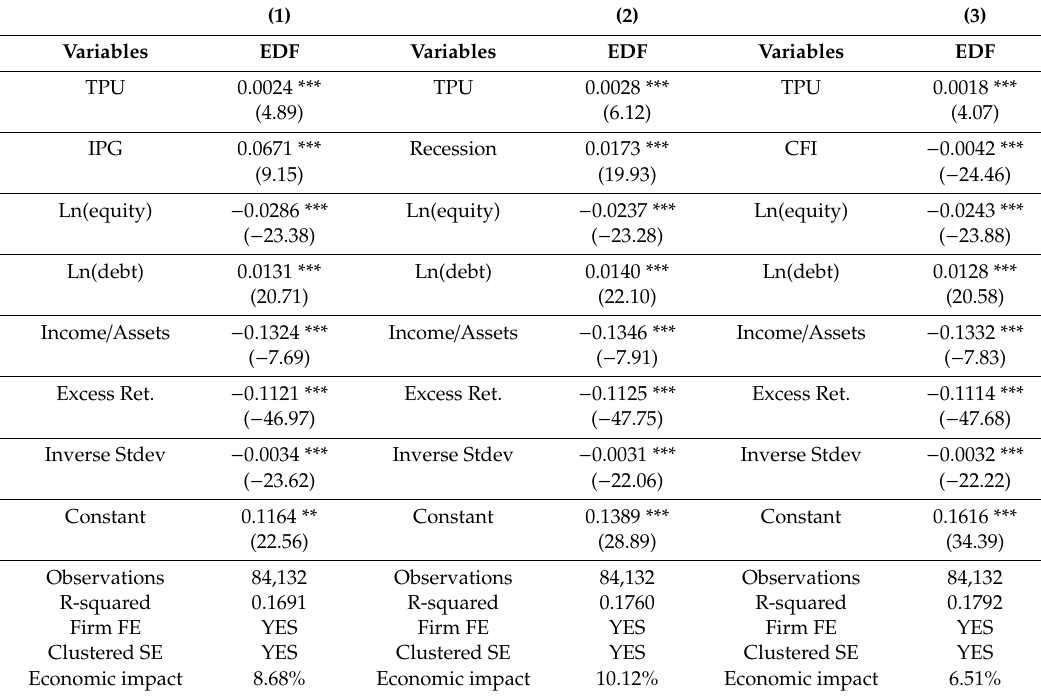
Table 3. Impact of tax policy uncertainty on default risk conditioned on the overall economy—this table presents firm fixed e ff ects regression results for the impact of tax policy uncertainty on default risk. The sample has 9888 unique firms and 84,132 firm-year observations from 1987 to 2019. In all models, the dependent variable is the expected default frequency ( EDF ). The main variable of interest tax policy uncertainty (TPU). All variables are defined in Appendix A. We proxy economic conditions as in (P á stor and Veronesi 2013). Specifically, we use industrial production growth (IPG), obtained from the Board of Governors. We proxy recessions with the National Bureau of Economic Research (NBER) recession dummy, equal to one during recession months and zero otherwise. We proxy economic activity with the Chicago Fed National Activity Index (CFI), constructed by the Federal Reserve from 85 monthly indicators of economic activity. The economic impact panel reports the economic impact of a standard deviation increase in TPU on default risk on a relative basis. T -statistics reported in parentheses are calculated using standard errors that are clustered at the firm level and are robust to heteroskedasticity. Symbols **, and *** indicate statistical significance at 10%, 5%, and 1% levels,